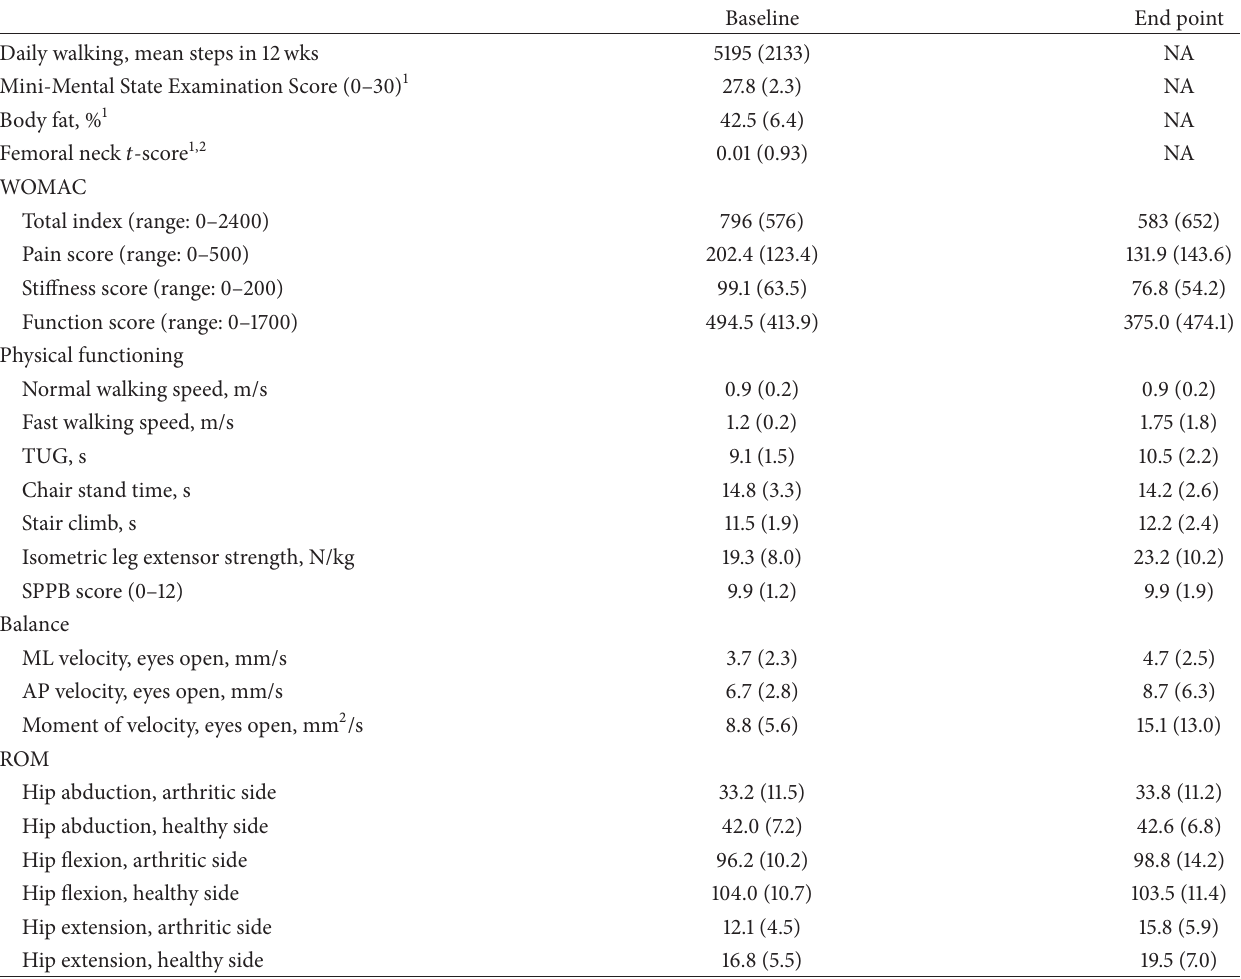
Table 1: Characteristics of the participants (mean